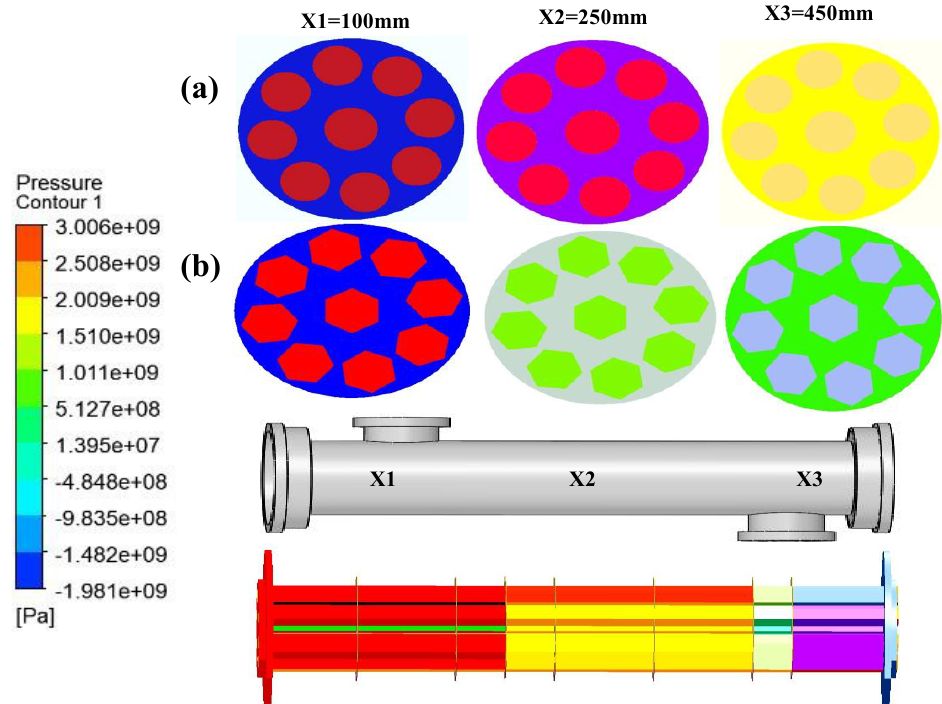
Figure 8. Pressure contours at cross-sections of ( a ) round tubes and ( b ) hexagonal tubes of a heat exchanger at 100 mm, 250 mm, and 450 mm.